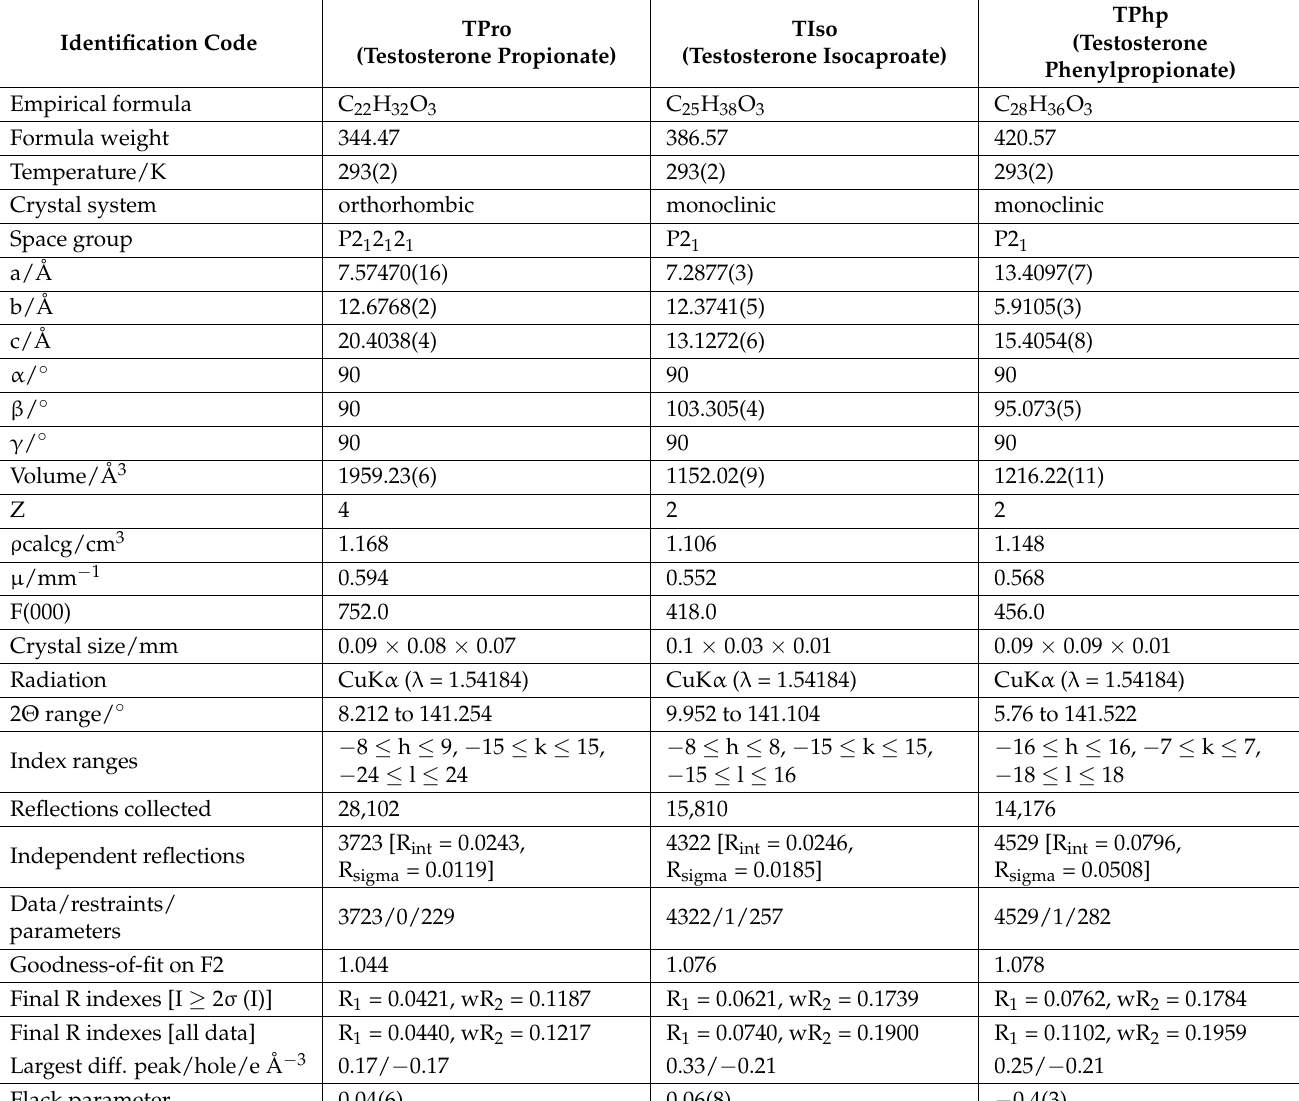
Table 1. Crystal structures and refinement data of investigated